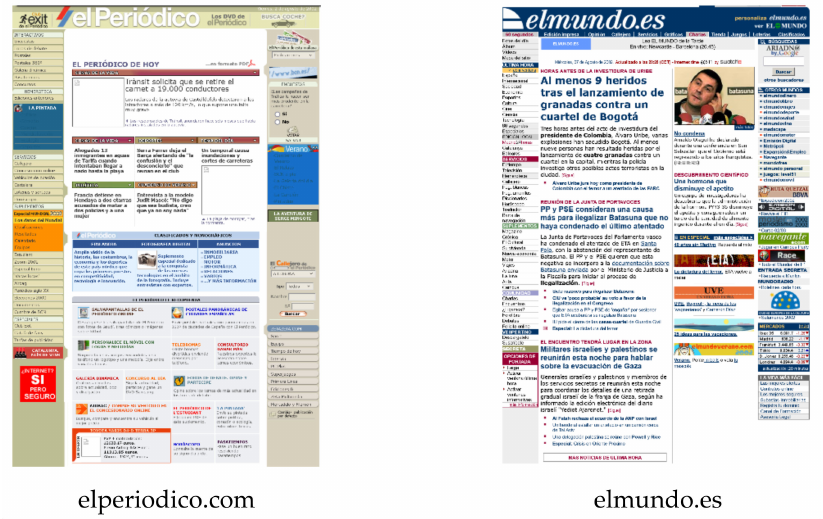
Figure 2. “Trident” structure in elperiodico.com and elmundo.es (August 2002). Compiled by the